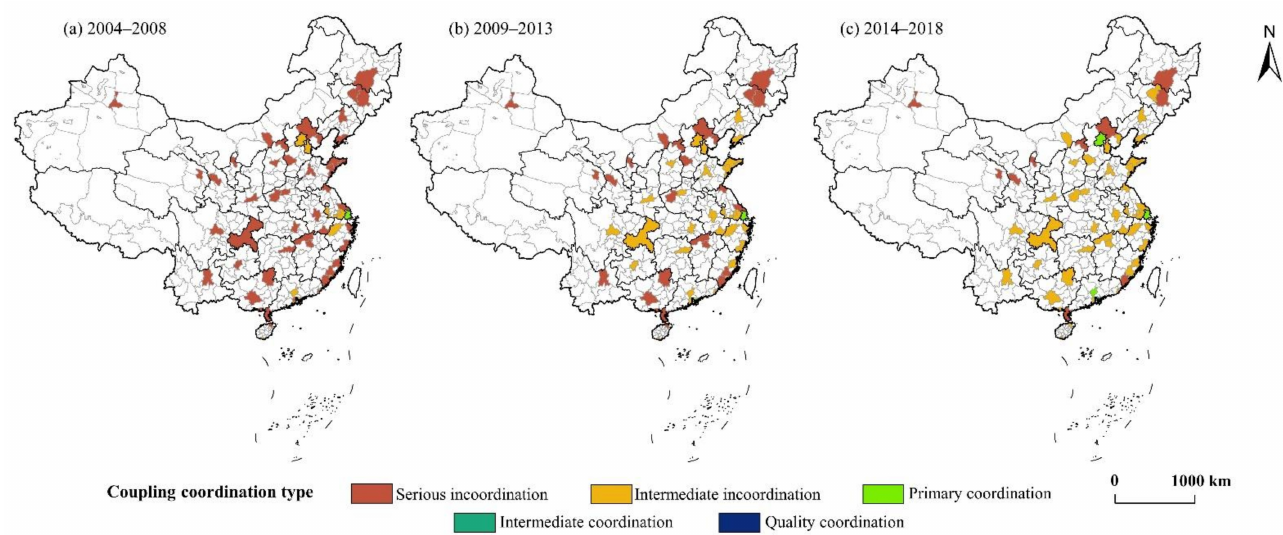
Figure 6. Variation in coupling coordination types of ILU and TID from 2004 to 2018.